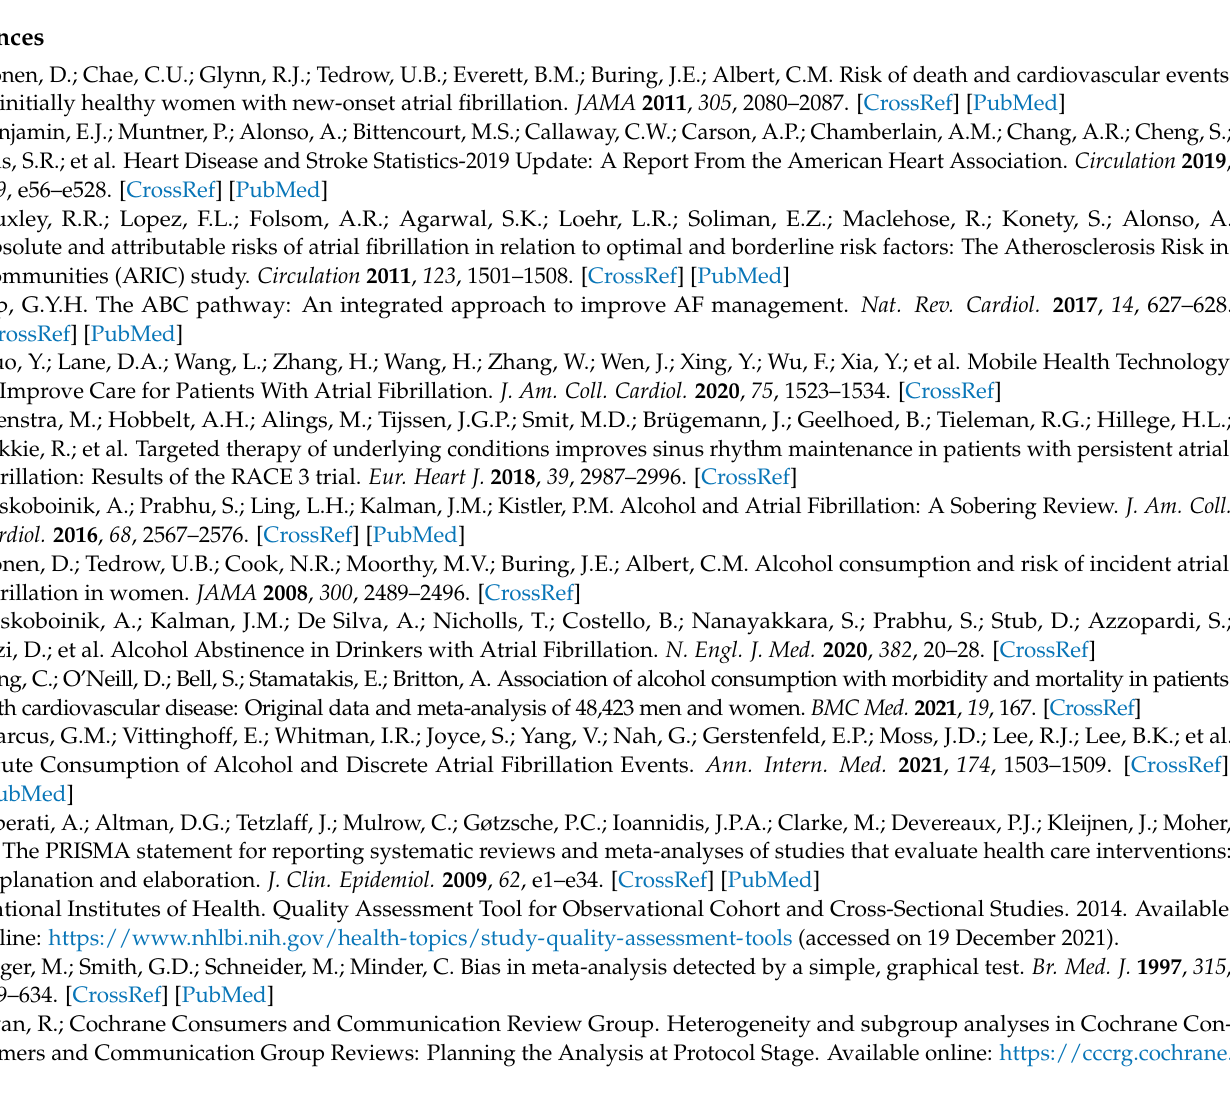
Contour enhanced funnel plot for the comparison between heavy and low alcohol consumption. Figure S2: Contour enhanced funnel plot for the comparison between moderate and heavy alcohol consumption. Figure S3: Contour enhanced funnel plot for the comparison between moderate and low alcohol consumption. Figure S4: Comparison between heavy and low alcohol consumption regarding incident AF. Sensitivity analysis. Figure S5: Comparison between moderate and heavy alcohol consumption regarding incident AF. Sensitivity analysis. Figure S6: Comparison between moderate and low alcohol consumption regarding incident AF. Sensitivity